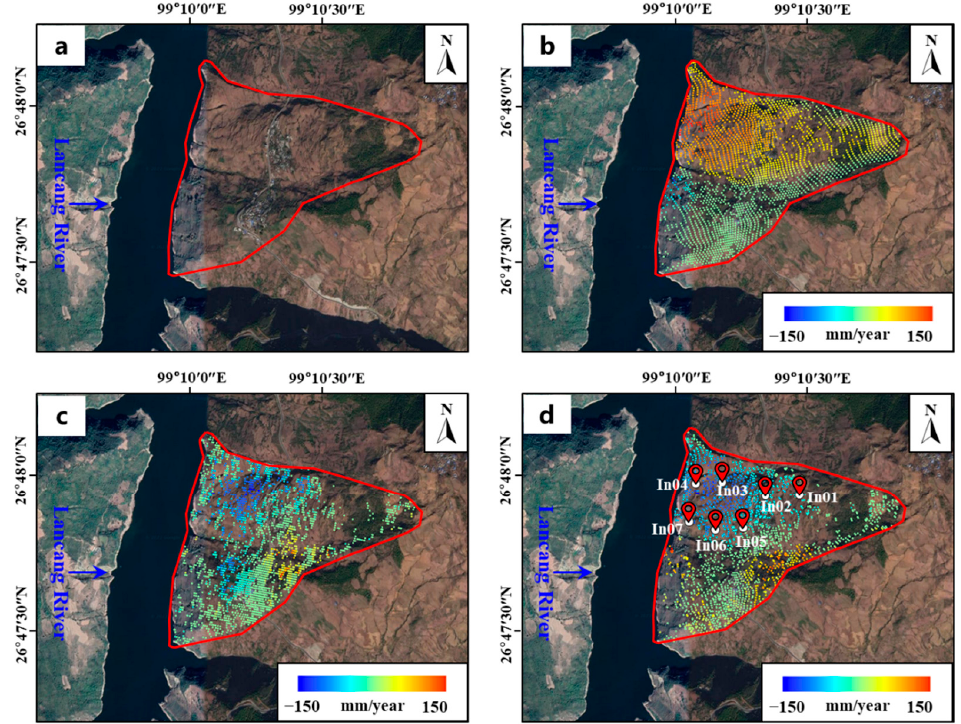
Figure 6. Mapping and monitoring of the Cheyiping landslide using Sentinel-1 InSAR data stack: ( a ) Aerial view of the Cheyiping landslide ( b ) Mean LOS displacement rate map of ascending InSAR measurements; ( c ) Mean LOS displacement rate map of descending InSAR measurements. ( d ) East-west displacement rate map.